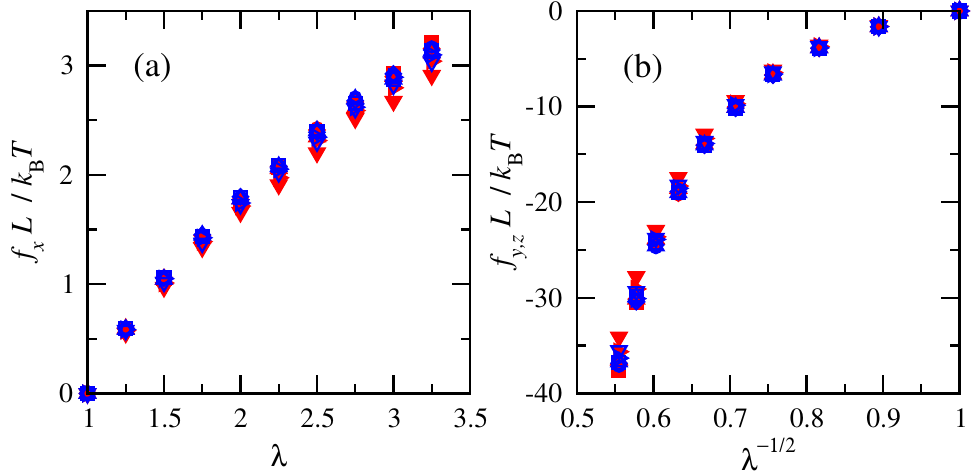
Figure 4. Normalized ( a ) tension and ( b ) compression forces vs. deformation ratio for cis- and trans-1,4-polybutadiene RIS chains of all sizes at 343 K. Filled red symbols for cis and open blue for trans. n = 15 ( (cid:79) ), 25 ( (cid:46) ), 50 ( (cid:52) ), 75 ( (cid:3) ), 100 ( (cid:5) ), and 120 ( ◦